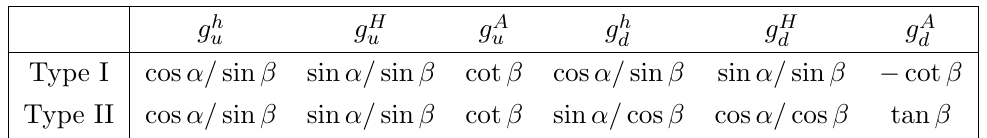
for 2HDM type I and II, see (cid:12)gure 5. For types III and f